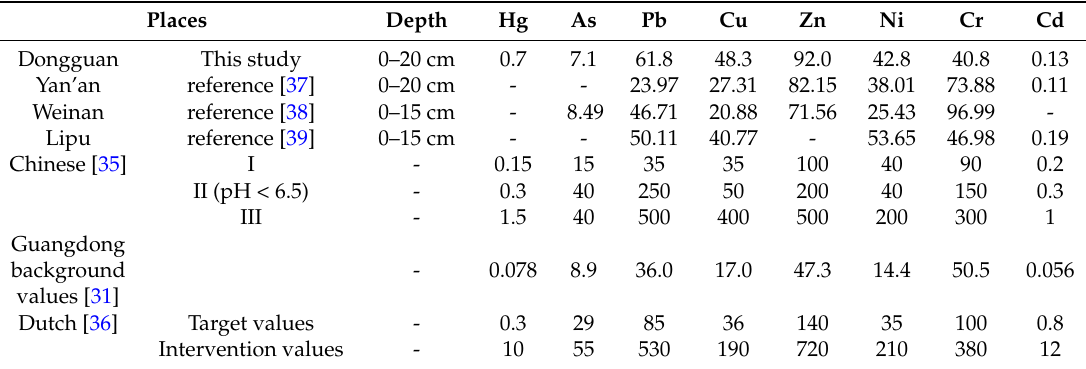
Dutch [36] Target values